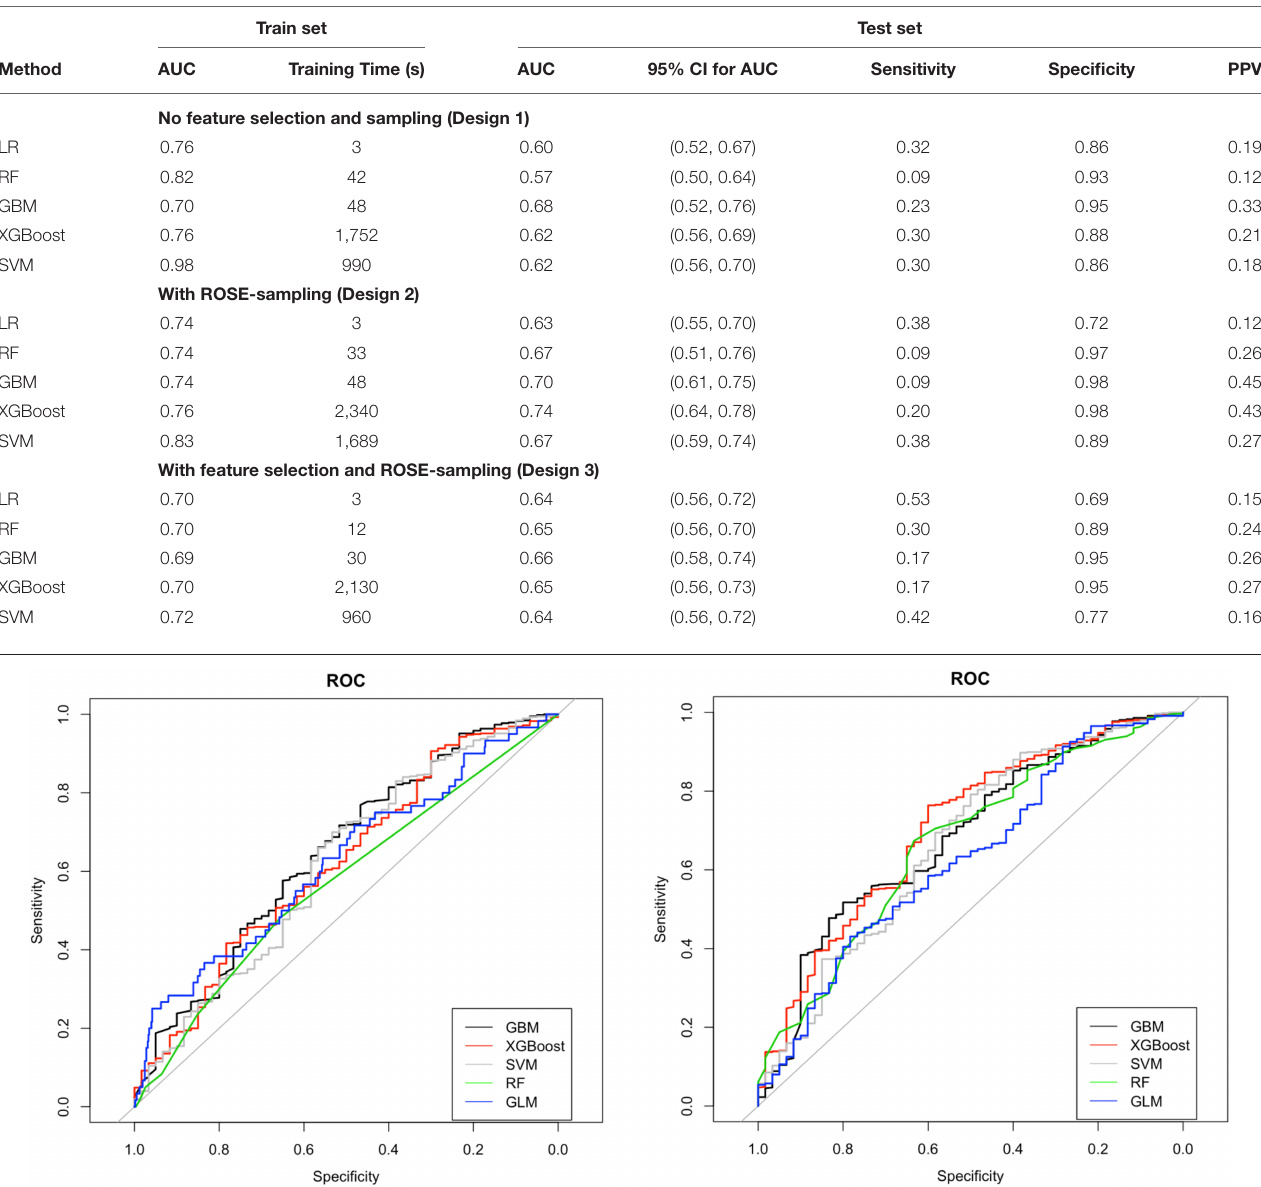
TABLE 2 | Performance metrics for machine learning models.